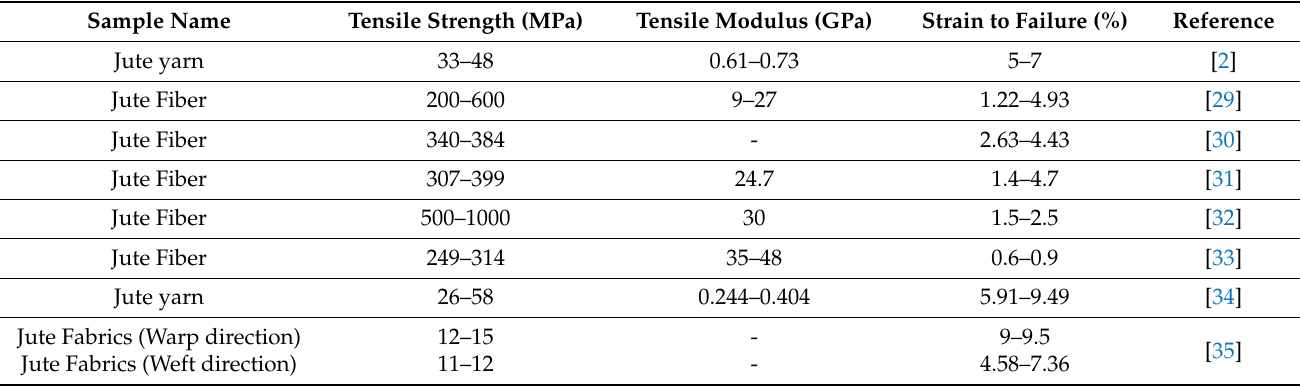
Table 1. Tensile properties of jute Figure 4. Microstructural characteristics of jute: ( a ) X-Ray diffraction and ( b ) FTIR spectra [28].